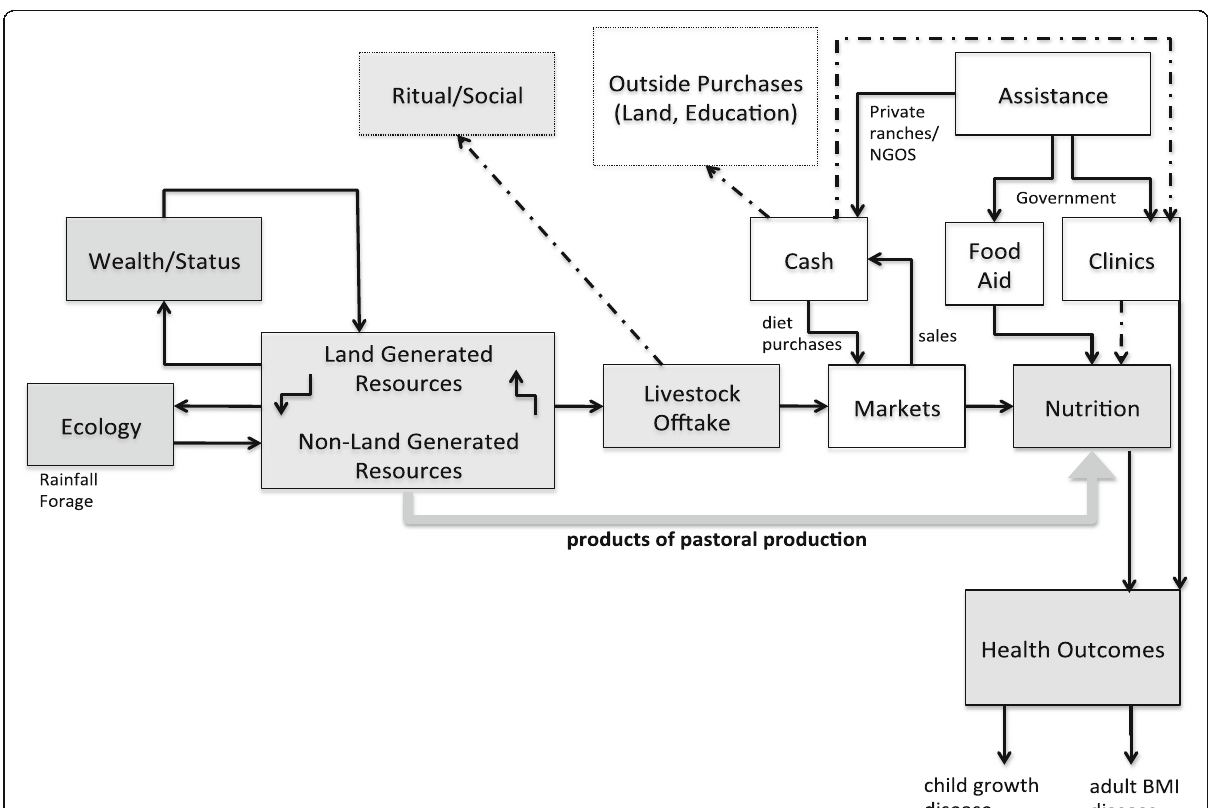
Figure 1 Conceptual framework of the current study. Hatched lines indicate hypothesized linkages. Shaded boxes indicate the traditional model of pastoralism we refer to in the text whereas the white boxes are the new elements that we have added to the framework in this